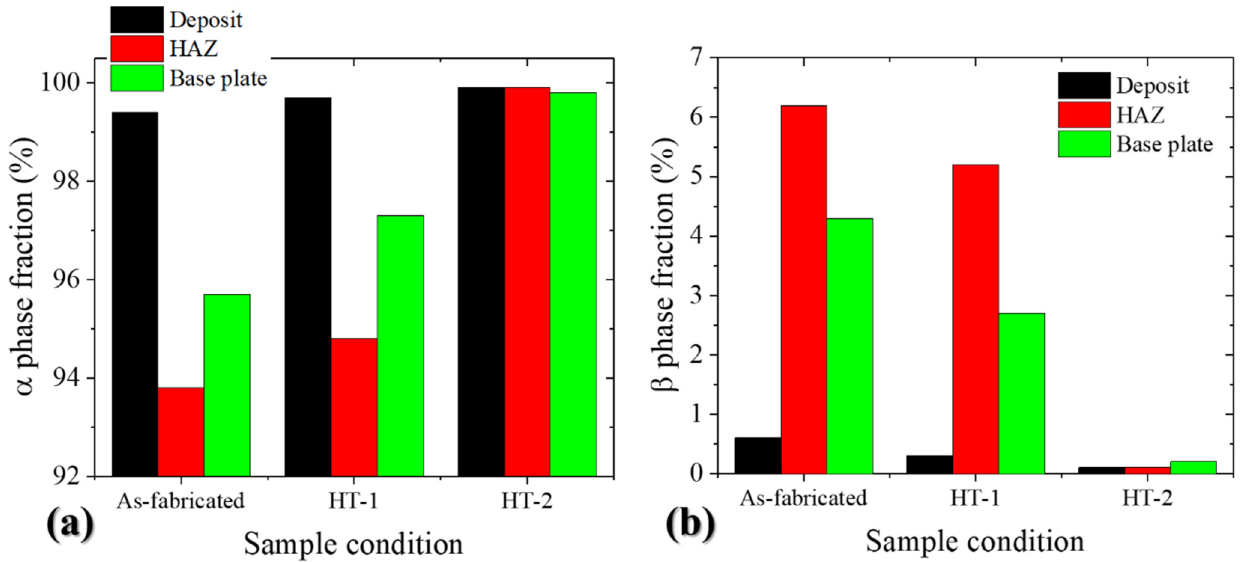
Figure 11. Variation in the phase fractions in the deposition region, heat-affected zone (HAZ), and base plate after direct energy deposition processing of the Ti–6Al–4V alloy: ( a ) α fraction and ( b ) β fraction.